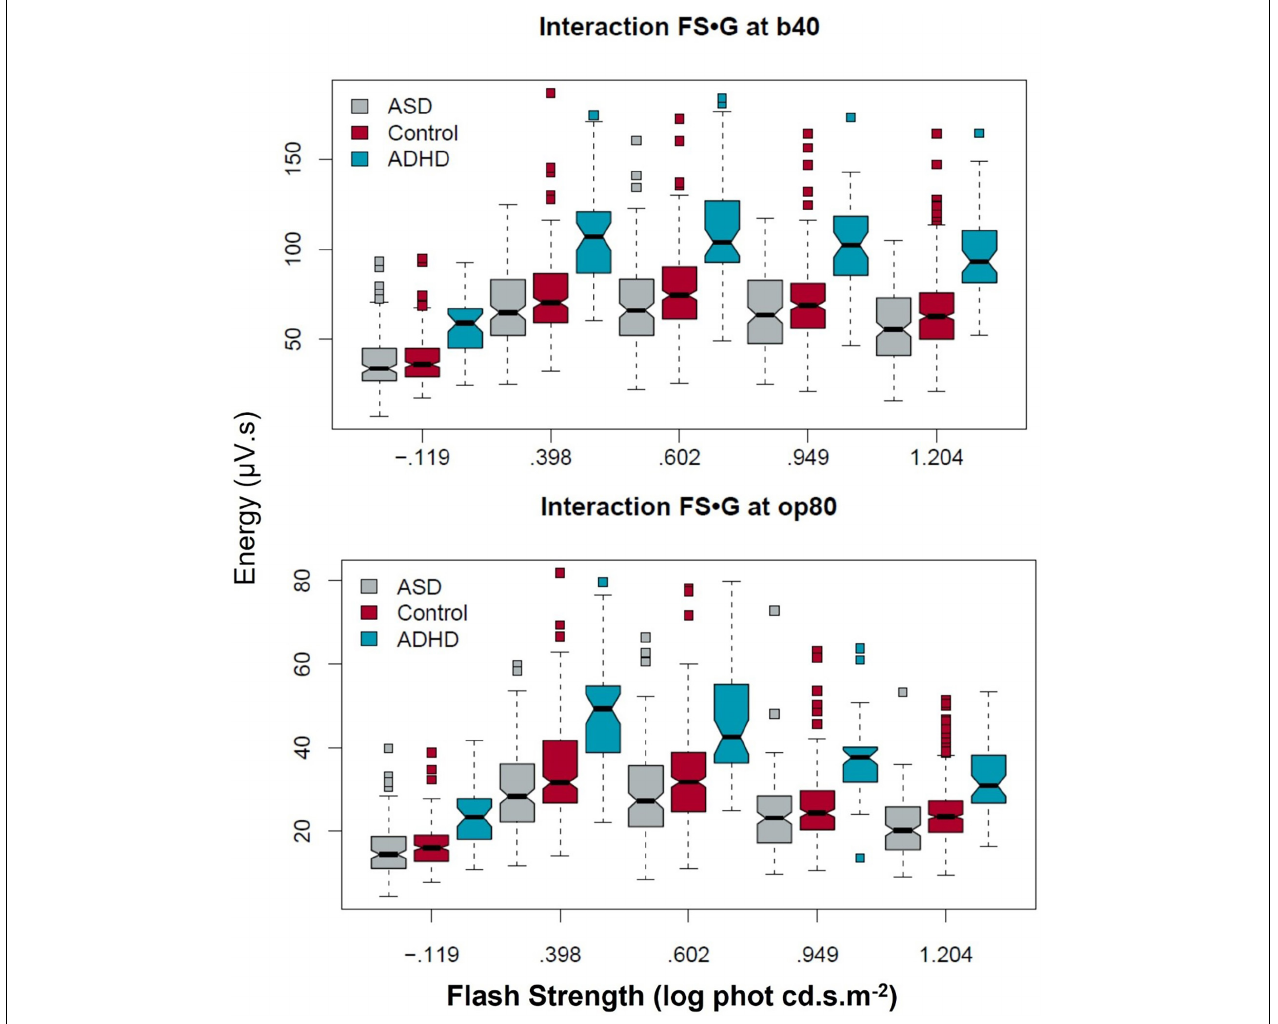
FIGURE 2 | Group differences in the b40 and op80 DWT coefficients across the five flash strengths. The ADHD group exhibited higher b40 and op80 energy levels across the flash series. In contrast the difference between ASD and controls was more significantly reduced for the op80 energy compared to the b40 at the higher flash strengths. Boxplots display ∼ 95% CIs around the median